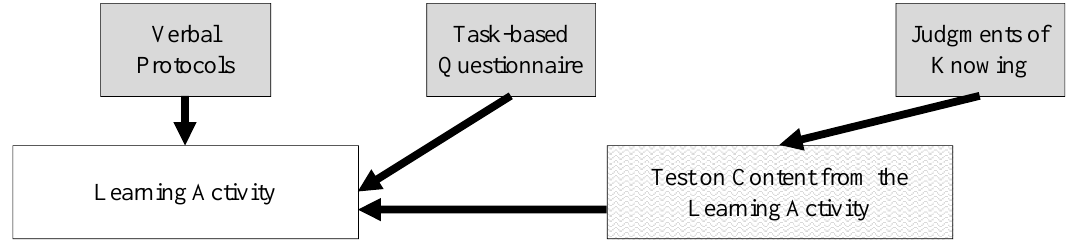
Figure 2. Visual representation of our across-methods-and-time design. The arrows indicate what each measure references. The verbal protocols were collected as a concurrent measure in reference to the learning activity. The task-based questionnaire was collected as a delayed retrospective measure in reference to the learning activity. The JOKs were collected as an immediate retrospective measure in reference to the test that was based on the learning content. Note, however, that the JOKs may act more like concurrent measures, as they are generated with the information still present (e.g., problem content); therefore, the box with JOKs overlaps more with the test on the learning activity, whereas the task-based questionnaire does not overlap with the learning activity.